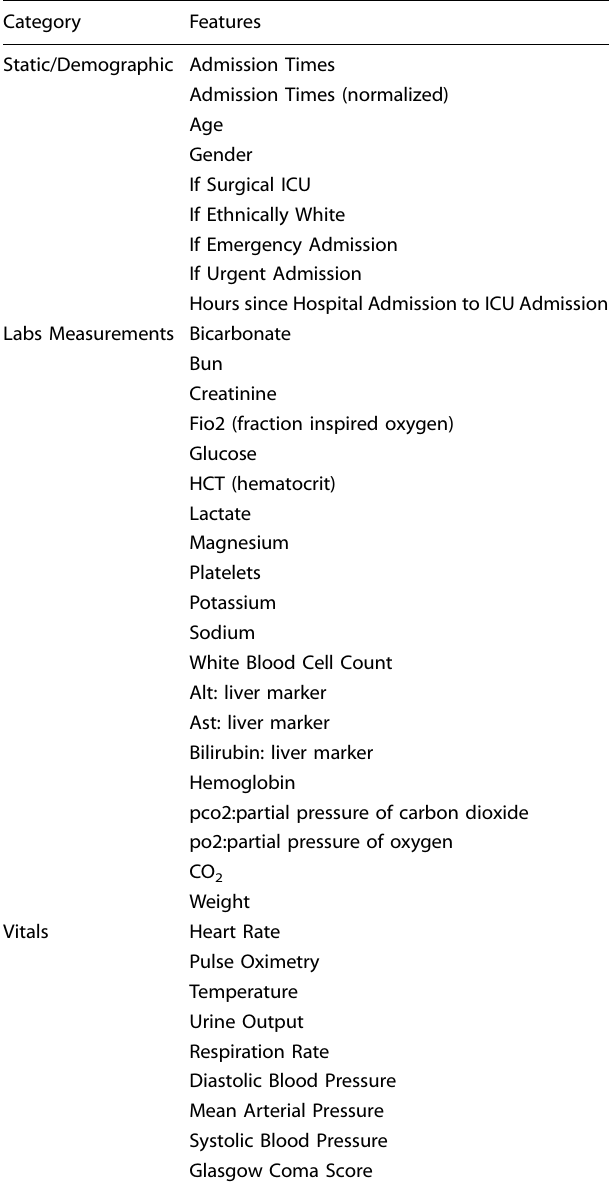
Table 2. List of clinical features considered from the MIMIC-III dataset.